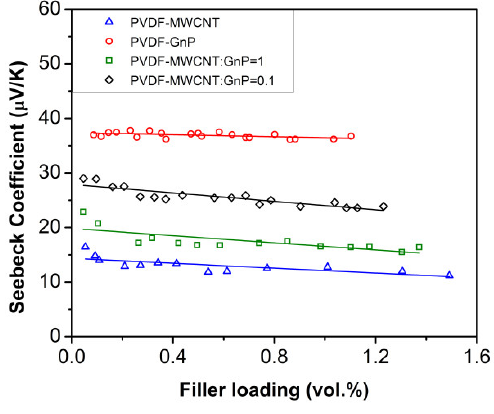
Figure 5. Seebeck coefficients of PVDF nanocomposites foams as a function of filler loadings.